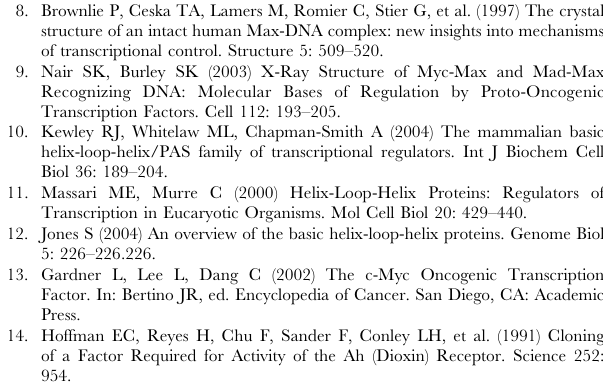
Figure S4 Circular dichroism. Spectra of ArntbHLH (red line) and ArntbHLH-C/EBP (blue line). Samples contained 2 m M ArntbHLH or ArntbHLH-CEBP. Buffers used are as follows: Buffer D: 15.08 mM Na 2 HPO 4 , 4.92 mM KH 2 PO 4 , 50 mM NaCl; Buffer E: 15.08 mM Na